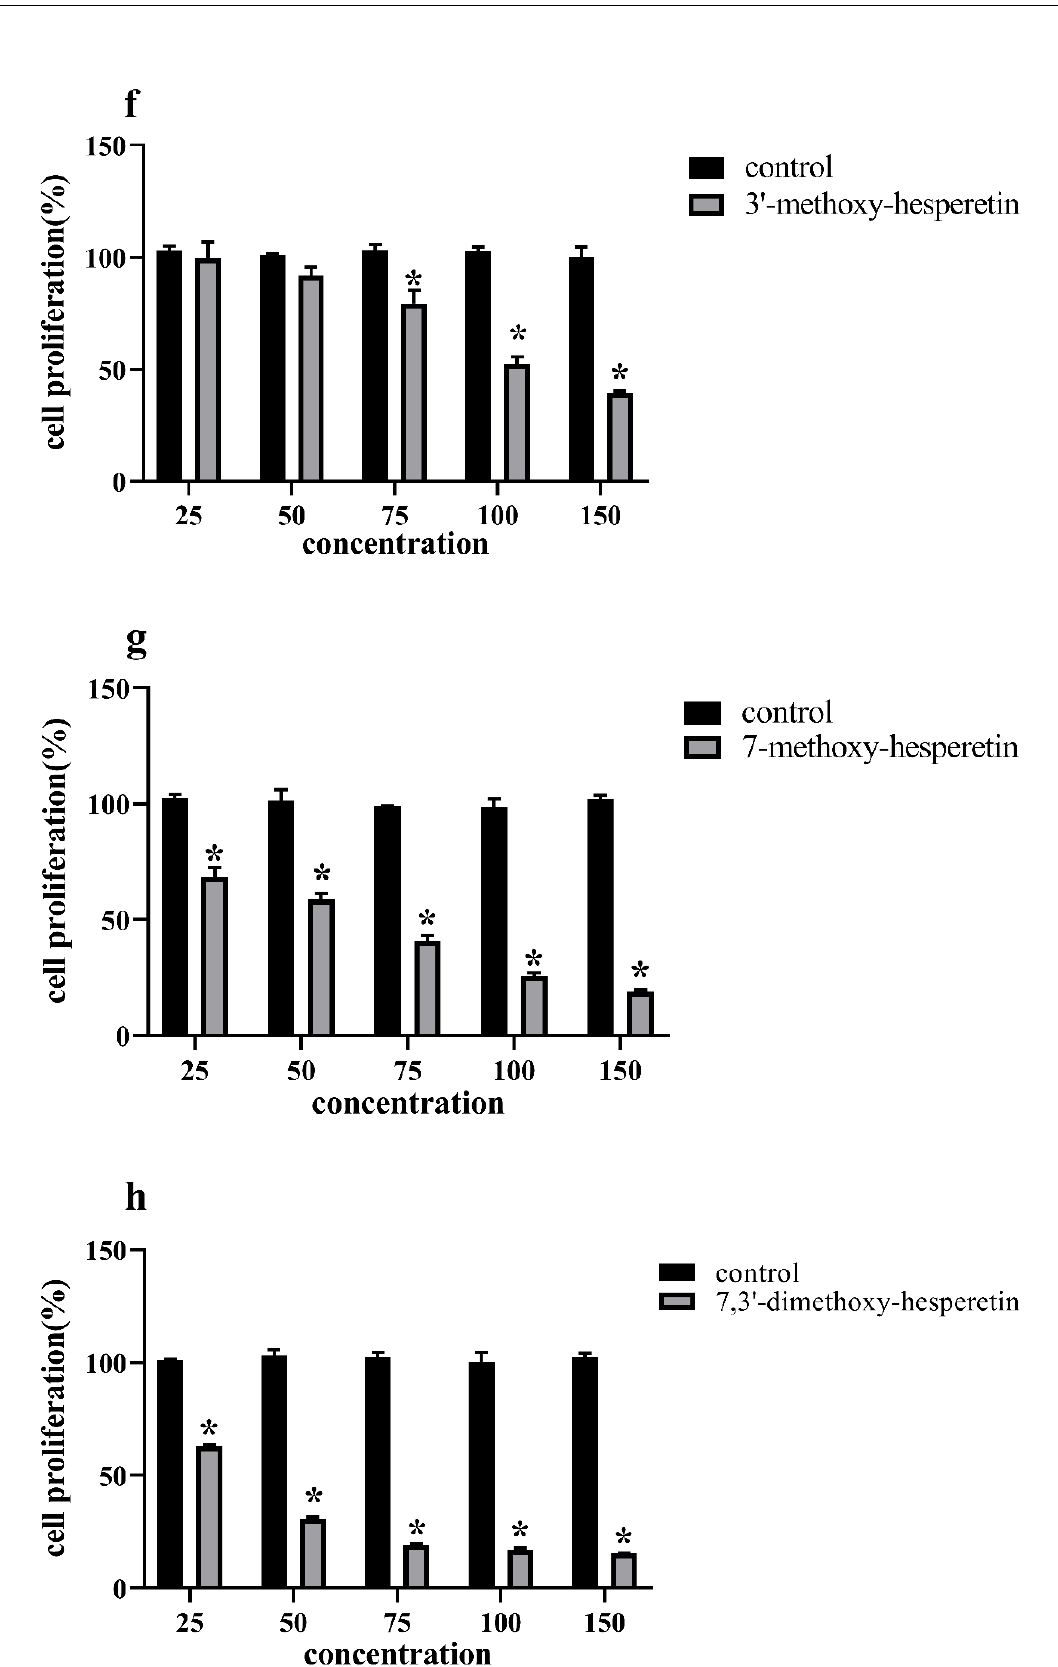
Figure 4. Inhibition of proliferation of MCF-7 human breast cancer cells by ( a , b ) liquiritigenin and 7-methoxy-liquiritigenin; ( c , d ) naringenin and 7-methoxynaringenin; and ( e – h ) hesperetin, 3′ - methoxyhesperetin, 7-methoxyhesperetin and 7, 3′ -dimethoxyhesperetin. (mean ± SD, n = 3). * Indi- cates a significant difference compared to the control ( p < 0.05).